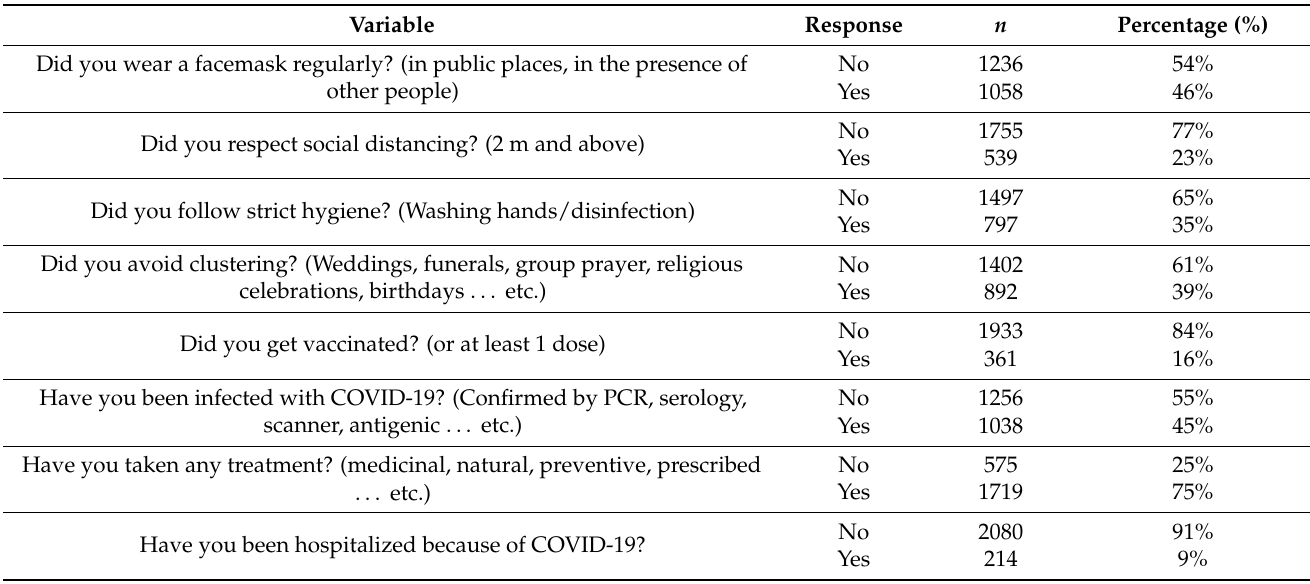
Table 1. Summary of received responses.